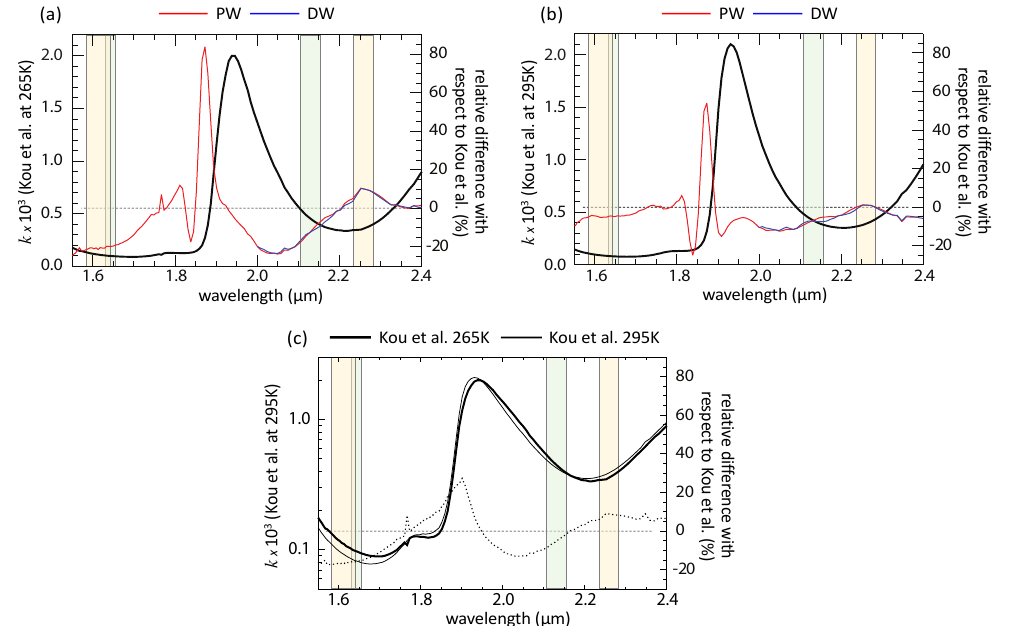
Figure 1. Liquid water spectral imaginary index of refraction ( k ) from three data sources from the 1.6 through 2.2 µ m SWIR atmospheric windows. The imaginary index of refraction is shown on the left ordinate by the thick black line for Kou et al. at laboratory temperatures of ( a ) 26 5 K and ( b ) 29 5 K. The percent difference relative to Kou et al. for the Palmer and Williams (PW) and Downing and Williams (DW) datasets, both for a nominal 30 0 K temperature, are shown on the right ordinate. The nominal half-power bandpasses for the relevant MODIS (green shading) and VIIRS (yellow) channels are also shown. The two Kou et al. datasets and their relative difference (dashed line) are shown in ( c ).